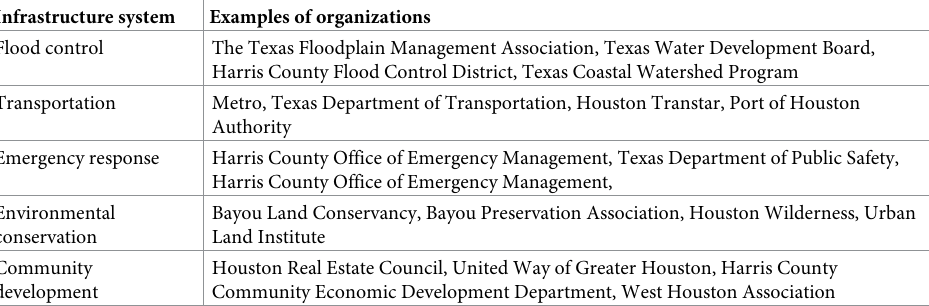
Table 1. Examples of organizations in each infrastructure